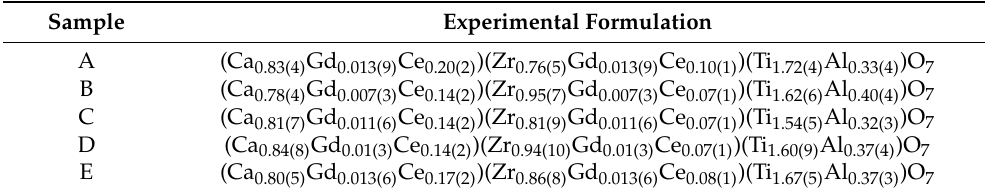
Table 4. Experimental compositions of different samples (Theoretical composition: